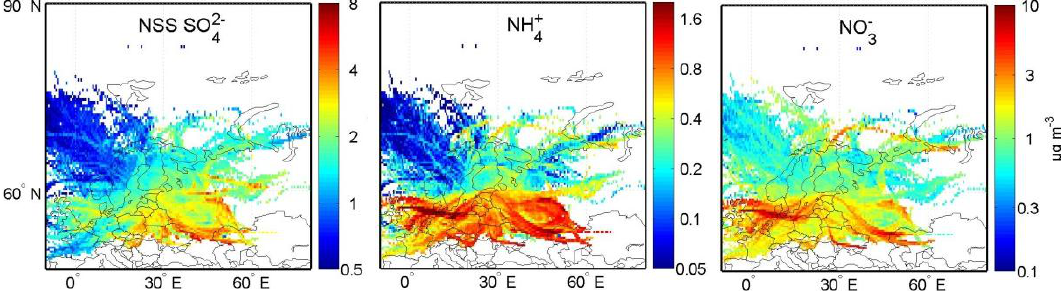
Fig. 14. Source areas of the most important secondary aerosol ion compounds as determined from trajectory statistics.